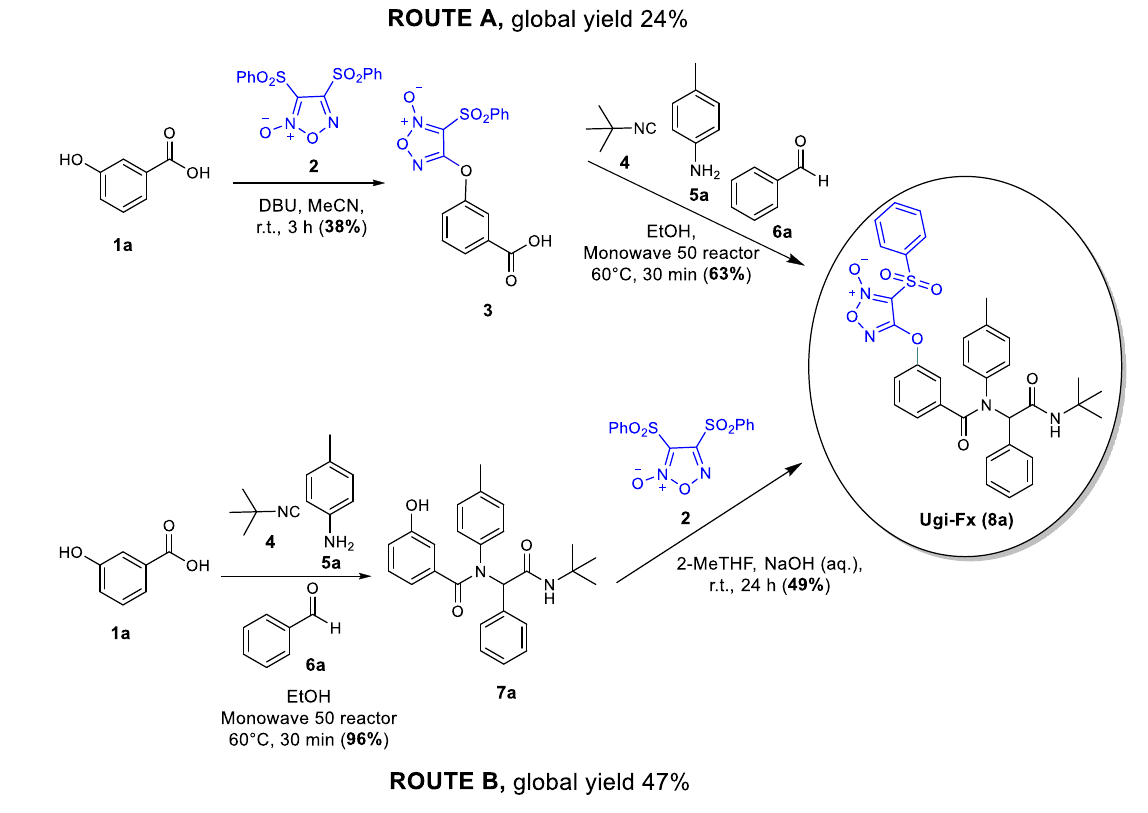
Scheme 1. Explored routes for the synthesis of Ugi-Fx ( 8a ).